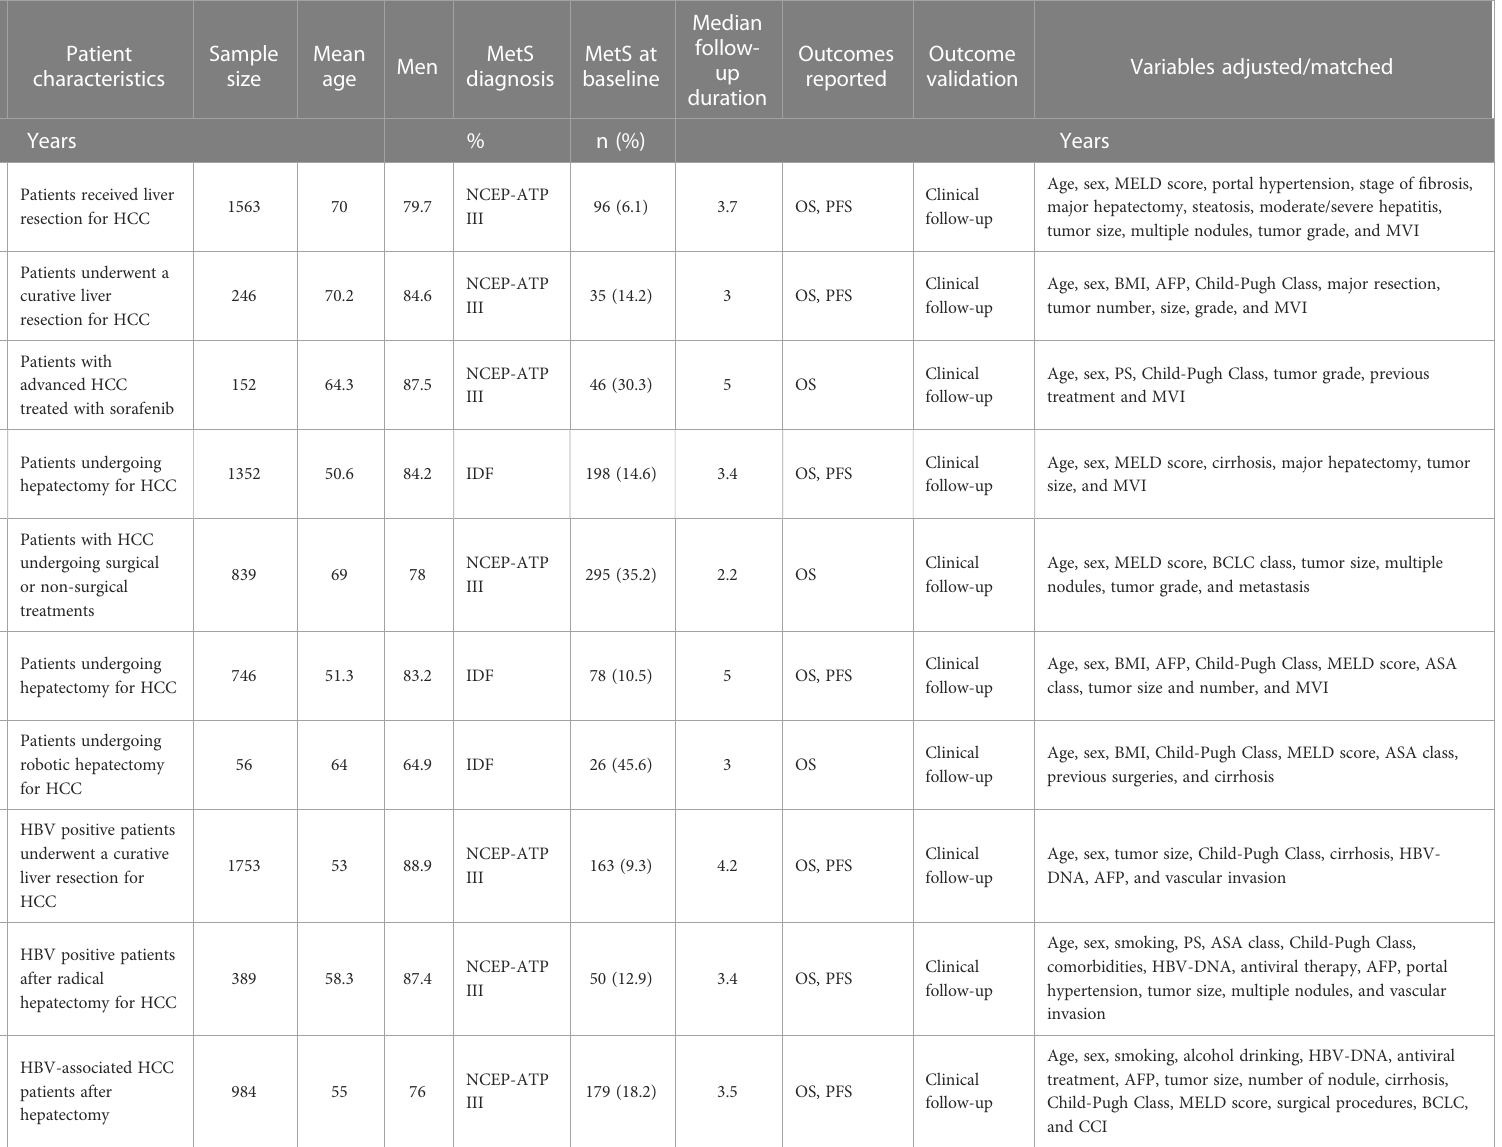
AFP, alpha-fetoprotein; ASA, American Society of Anesthesiologists; BCLC, Barcelona clinic liver cancer stage; BMI, body mass index; CCI, Charlson Comorbidity Index; HBV, hepatitis B virus; HCC, hepatocellular carcinoma; IDF, International Diabetes Federal; MetS, metabolic syndrome; MELD, Model for End-stage Liver Disease; MVI, microvascular invasion; NCEP-ATP III, National Cholesterol Education Program Adult Treatment Panel III; OS, overall survival; PC, prospective cohort; PFS, progression-free survival; PS, performance status; RC, retrospective